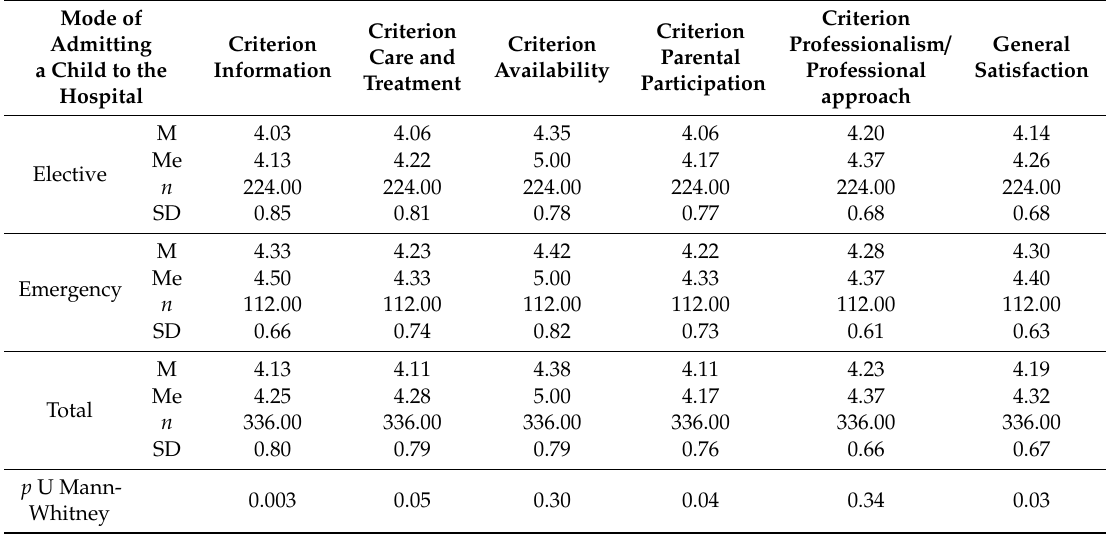
Table 3. Parental satisfaction with nursing team care and the mode of admitting a child to the